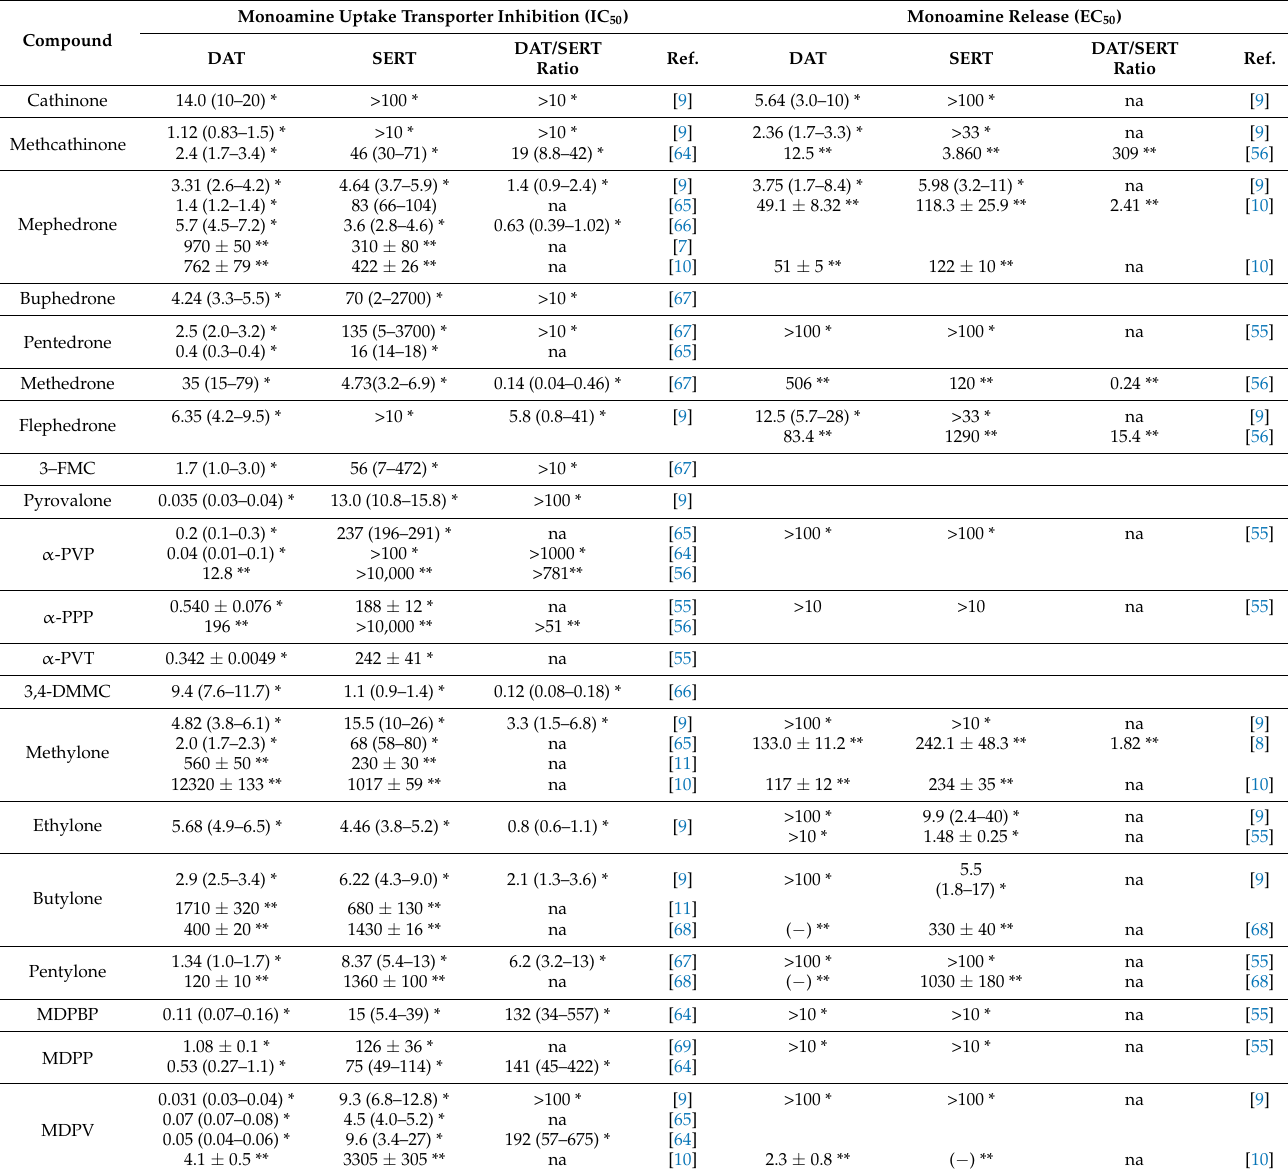
Table 1. In vitro dopamine and serotonin uptake transporter inhibition (IC 50 values) and release data (EC 50 values).